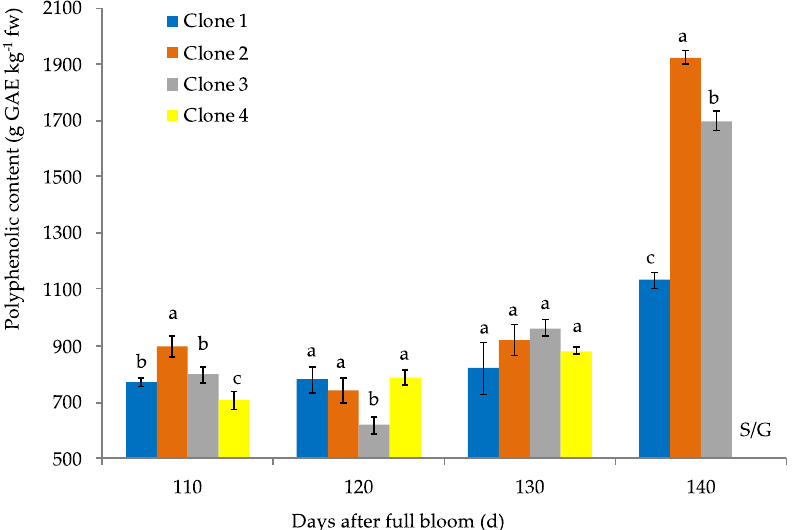
Figure 4. Total polyphenol content for the different calafate clones according to the different harvest dates. Lowercase letters indicate significant differences between the different clones for the same harvest date, according to the Fischer test ( p < 0.05). S/G = no harvest.